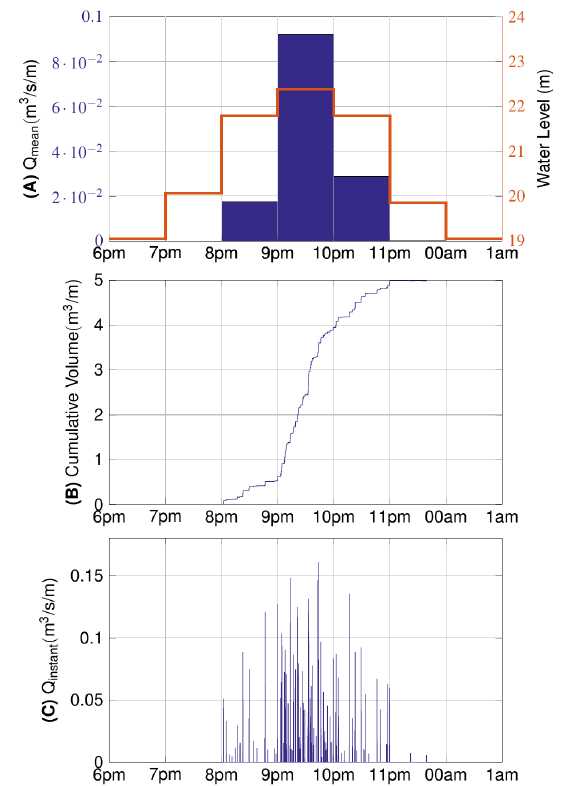
Figure 10. Modelled overtopping discharges for each hourly period. ( A ) the mean overtopping rate for each hourly period and water level used in the model; ( B ) the cumulative overtopping discharge during the storm period; ( C ) the instantaneous wave-by-wave overtopping